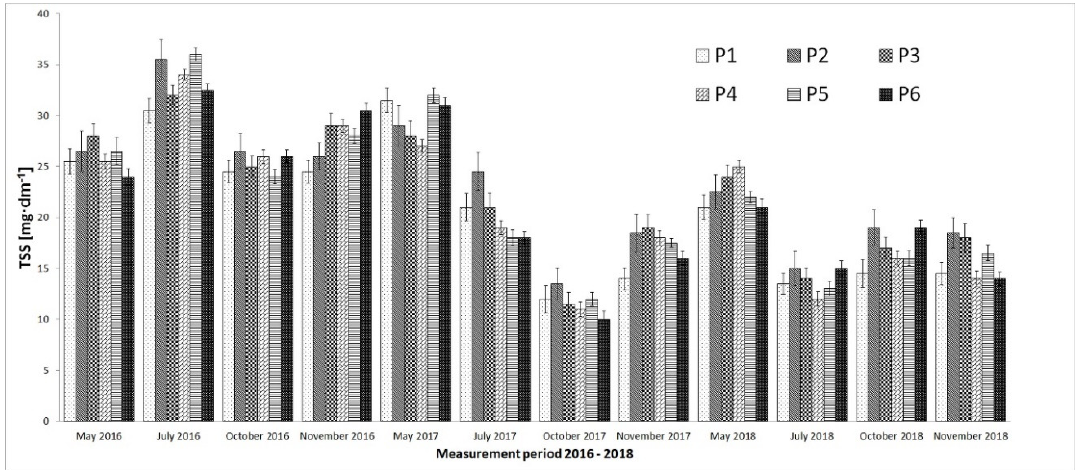
Figure 11. Changes in TSS (Total Suspended Solids) value at points P1–P6 in the reservoir. Measurement campaigns 2016–2018.